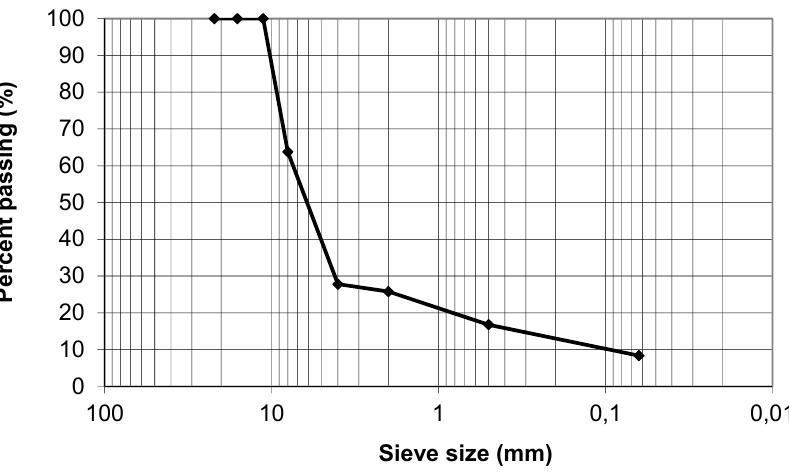
Figure 1. Grading curve of the mixtures.